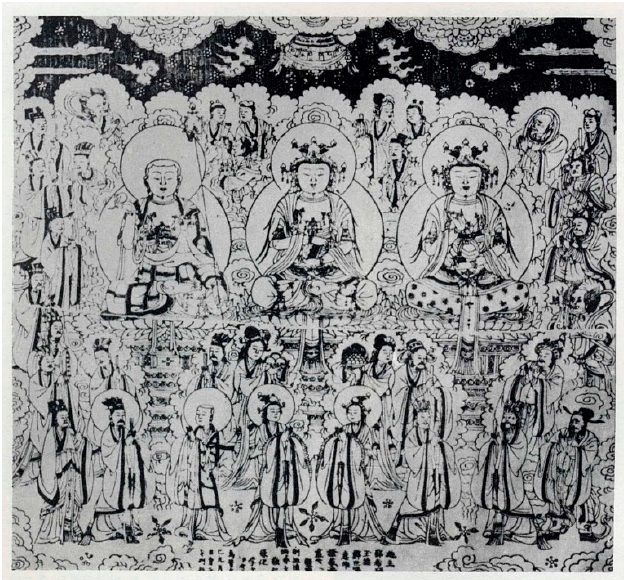
Figure 10. Three Bodhisattvas of the Three Stores (K. Samjang bosaldo ), Woodblock carved at Hoeansa Temple, Joseon (1581), 46.0 × 50.0 cm, Private collection. Source: (Gonggansa 1979, p. 42).